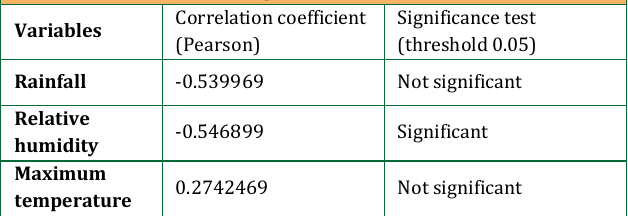
Table 3: Correlation analysis between burned areas and